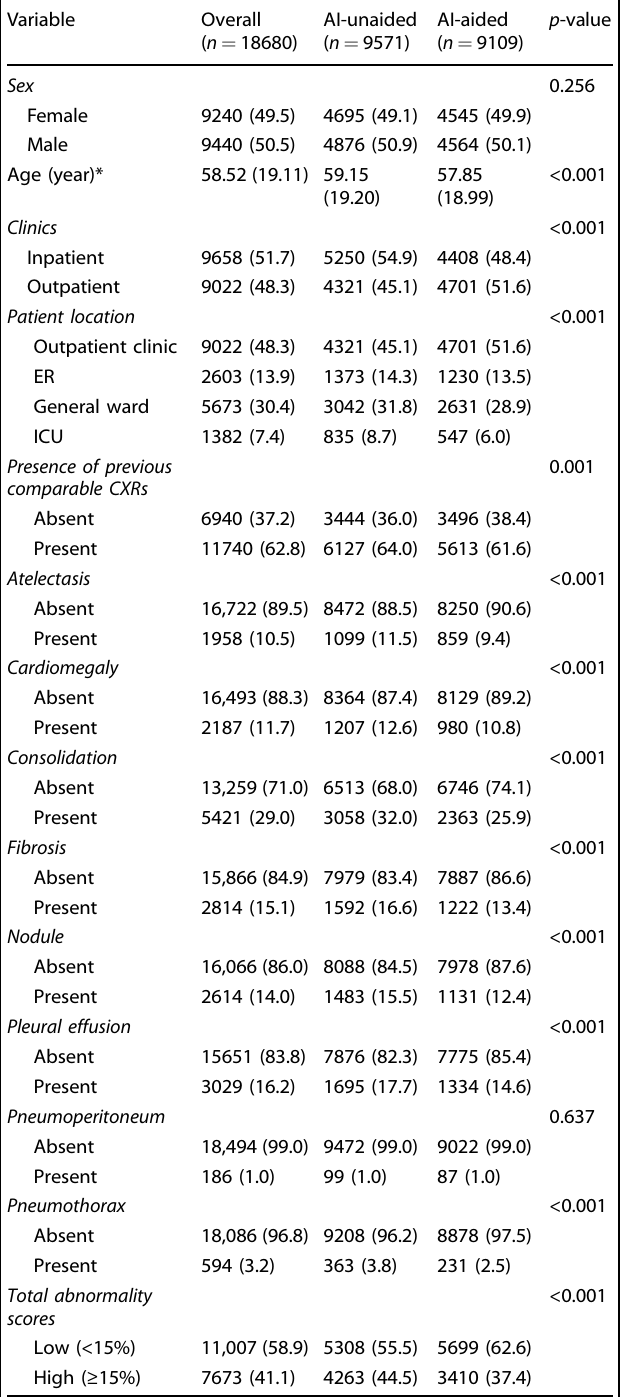
Table 1. Total number of chest radiographs in AI-unaided and AI- aided